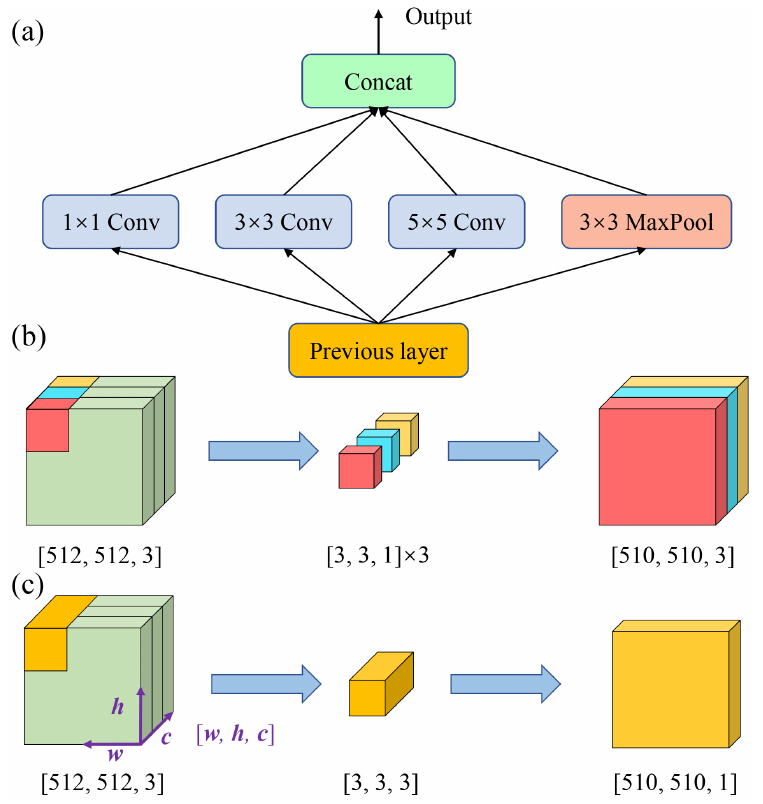
Figure 4. Schematic of: ( a ) inception; ( b ) depth-wise convolution; ( c ) standard convolution;